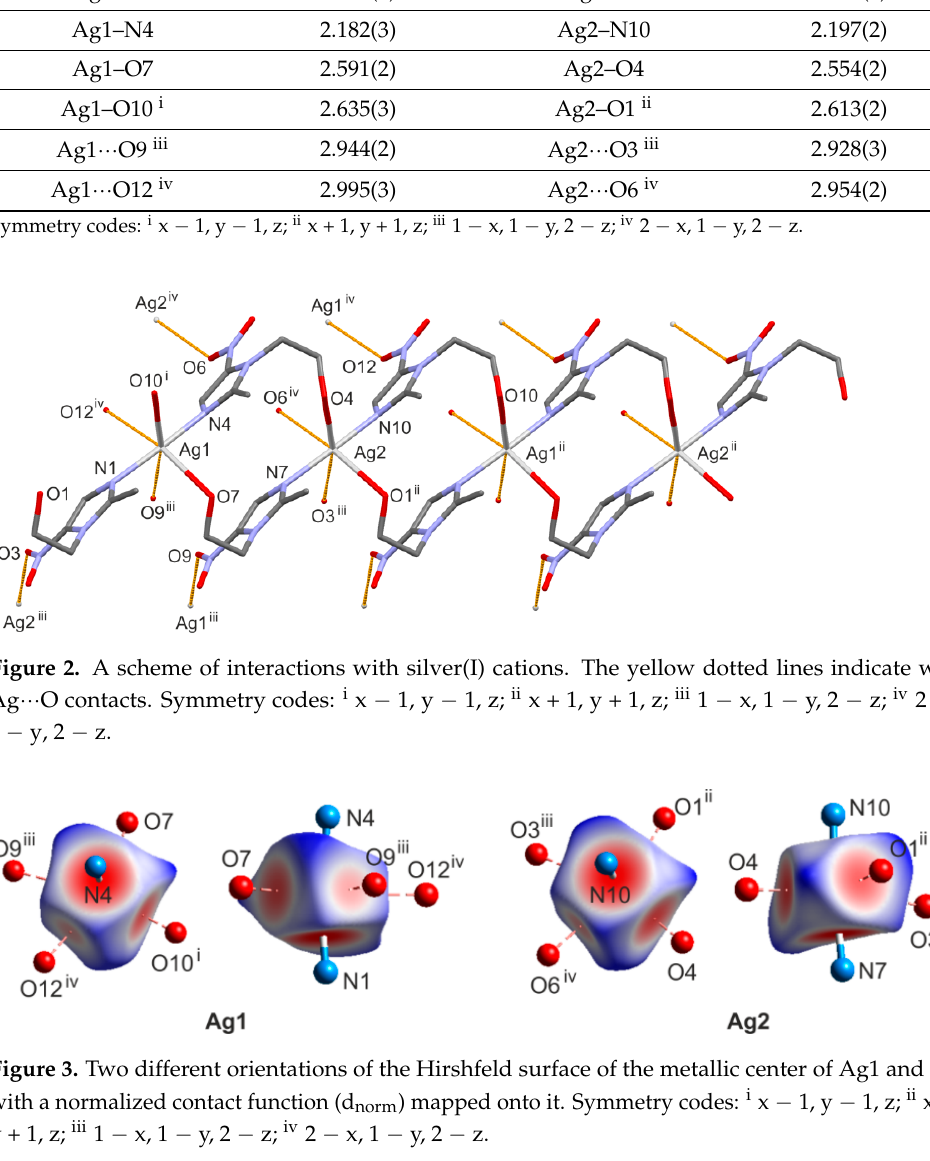
Figure 5. The crystal packing of the title complex.